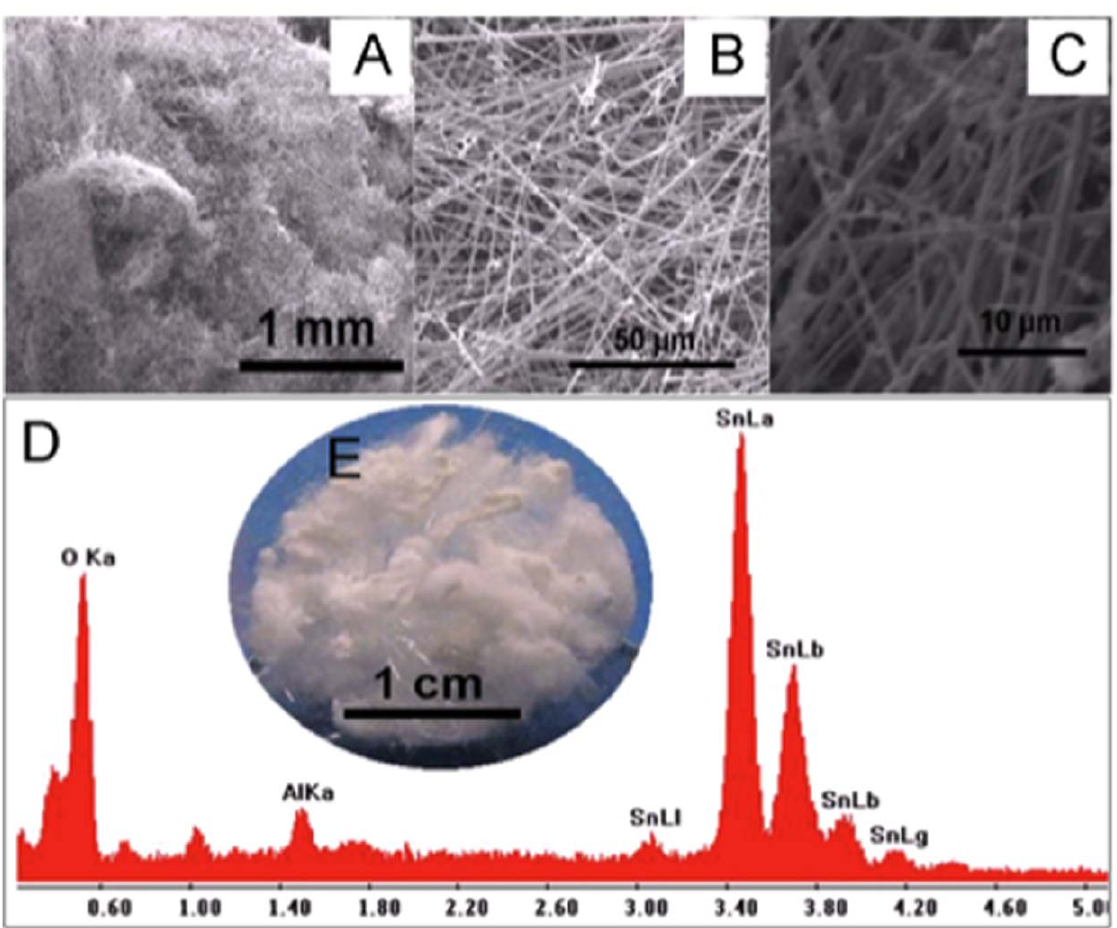
Figure 1. Scanning electron microscopy results of SnO 2 nanowires synthesized by flame transport approach. A)–C): SEM images of SnO 2 nanowires in increasing order of magnifications. D) Energy dispersive X-ray absorption (EDAX) spectrum showing the purity of SnO 2 nanowires. The inset E) in D) is the digital camera image demonstrating the wire type fluffy structures of tin